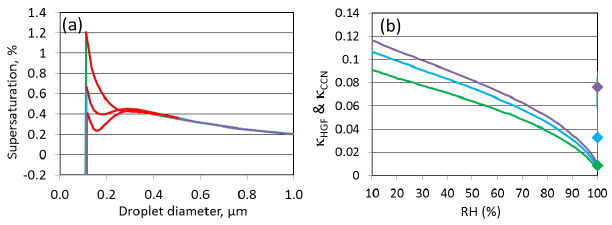
Figure 5. Assuming the surface tension of water, Köhler curves (panel a ) and hygroscopicity parameter κ (panel b ) for a par- ticle with a dry diameter of 100nm for SOM-high (green, O:C = 0.472), SOM-low (blue, O:C = 0.513) and SOM-ox (pur- ple, O:C = 0.582). The red segments on the lines in panel (a) indi- cate the presence of LLPS. In panel (b) , κ HGF is given as solid line as a function of RH and κ CCN as diamond at RH =